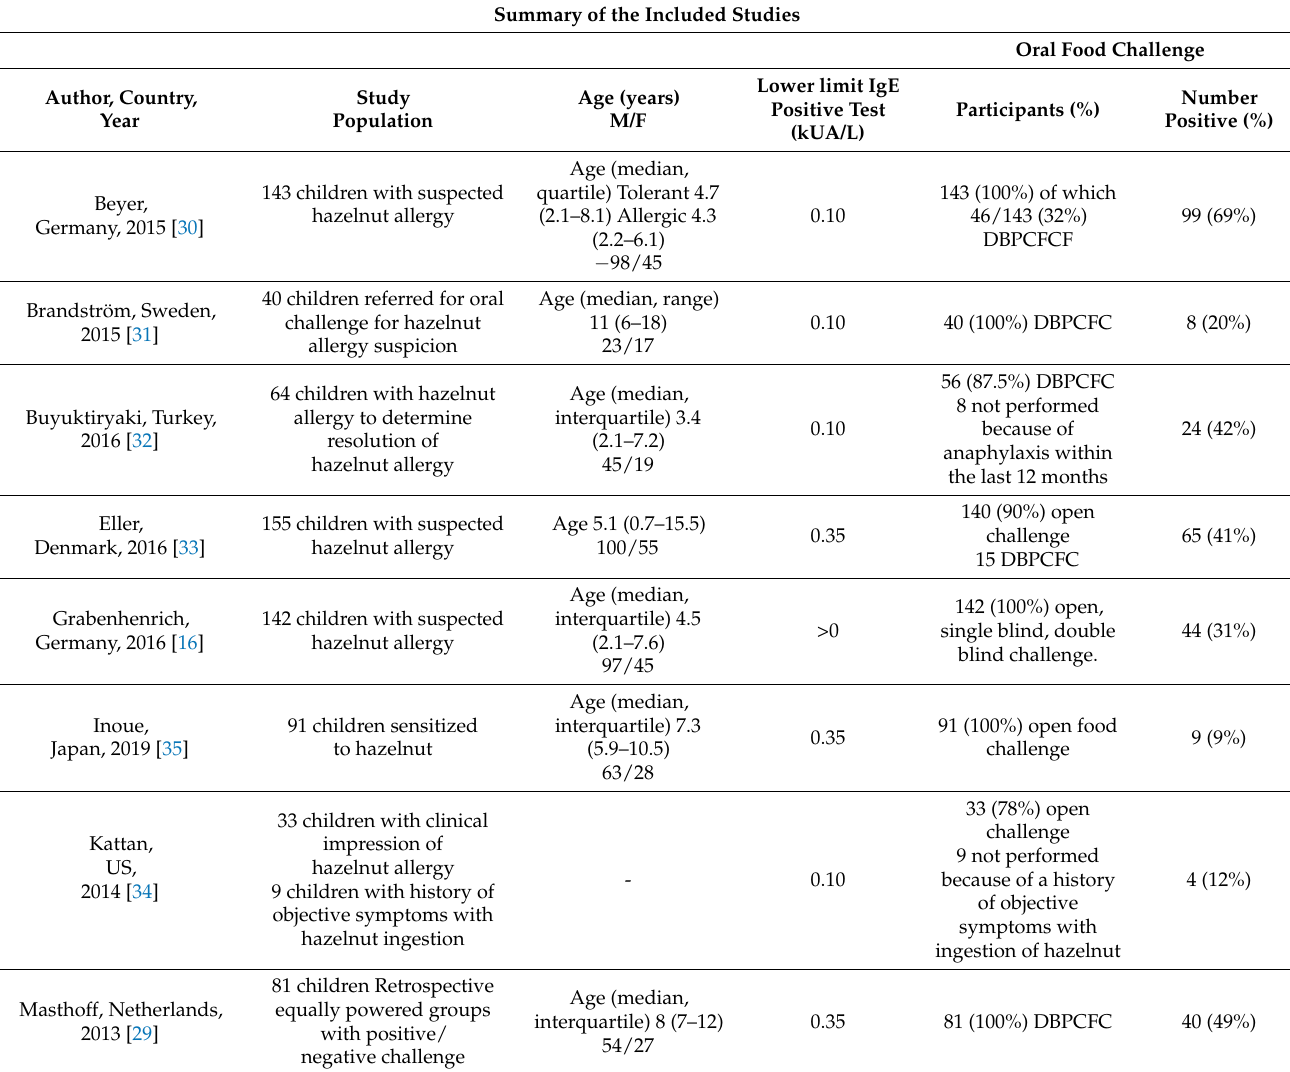
Table 1. Summary of the included studies. In all studies, specific IgE to Cor a 1, Cor a 8, Cor a 9, and Cor a 14 was measured. DBPCFCF = double-blind placebo-controlled food